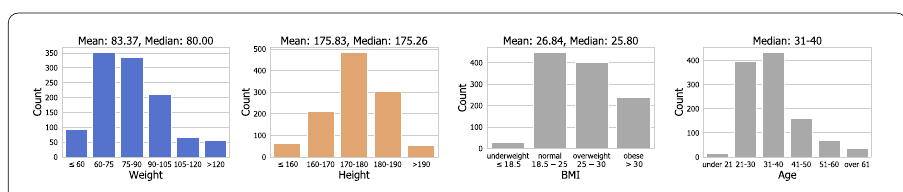
Figure 4 Men crowd workers (N = 1113, 45.9% of all